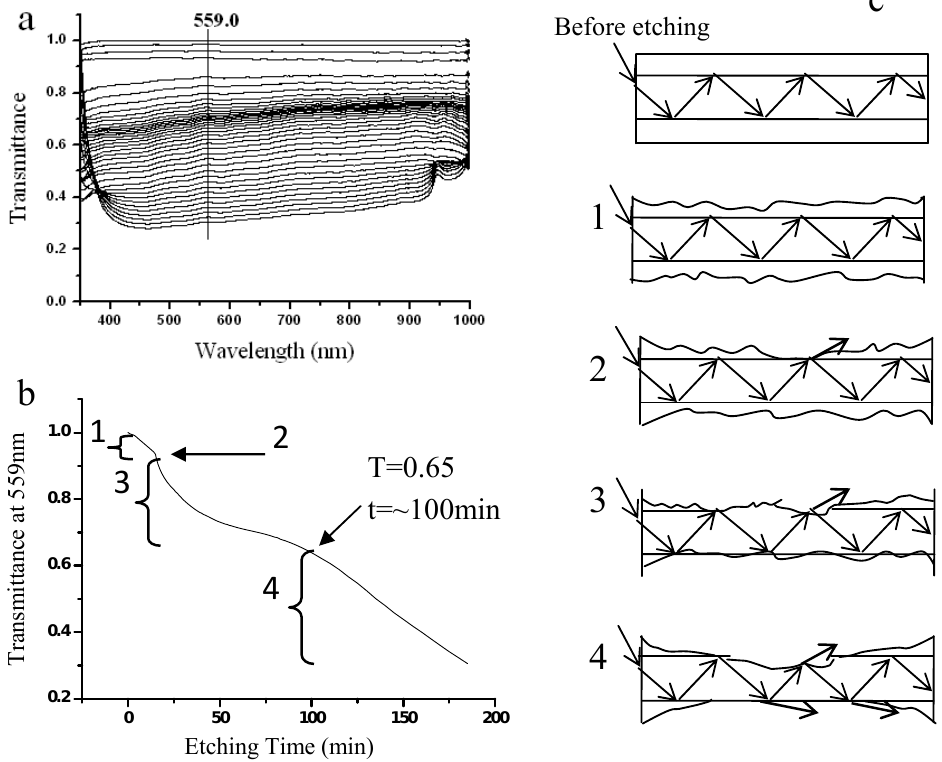
Figure 1 . (a) The transmission spectra at different etching time. (b) The transmittance at 559.0 nm as a function of the HF etching time. (c) The schematic drawing of the fiber optic at different etching